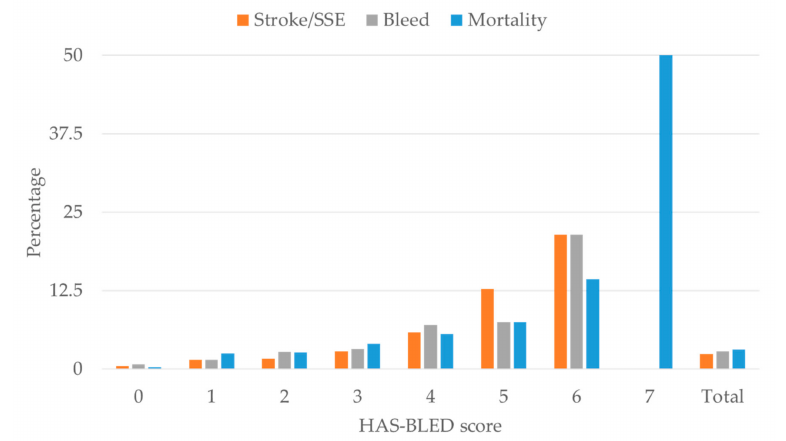
Figure 2. Outcomes (stroke / systemic embolic events (SSE), bleeding and mortality) by HAS-BLED risk score in the present